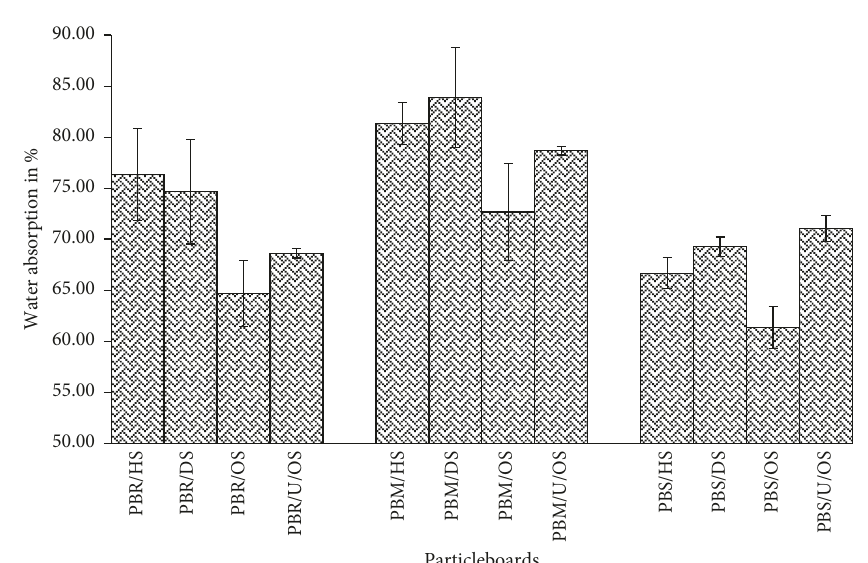
Figure 4: Water absorption (WA) of synthesized particleboards.